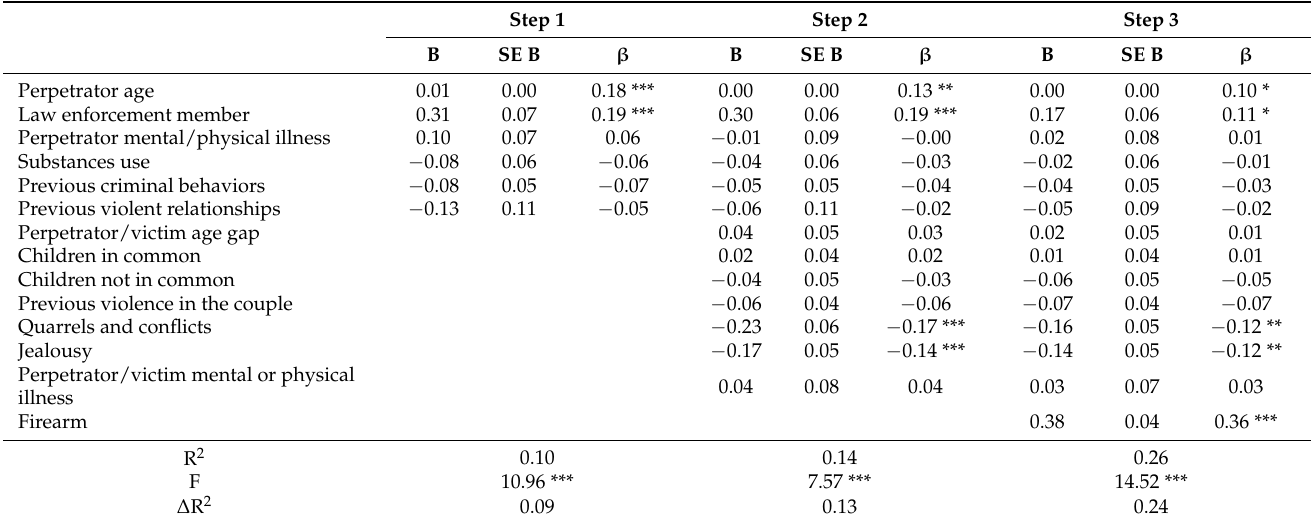
Table 3. Hierarchical regression including individual, relational, and contextual risk factors for IPFS. Step 1 Step 2 Step